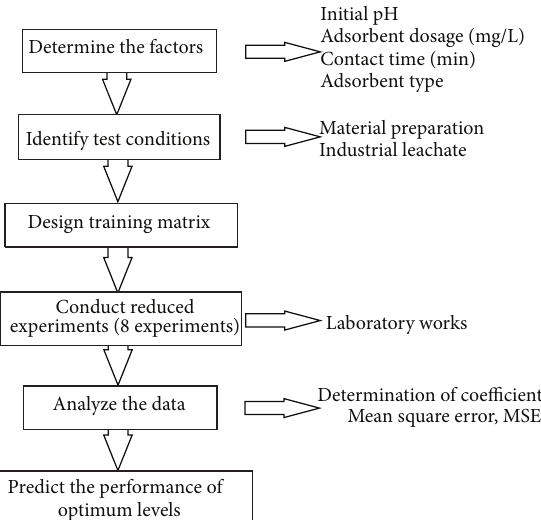
Figure 13: Cu(II) removal system based on CFNN by montmoril-